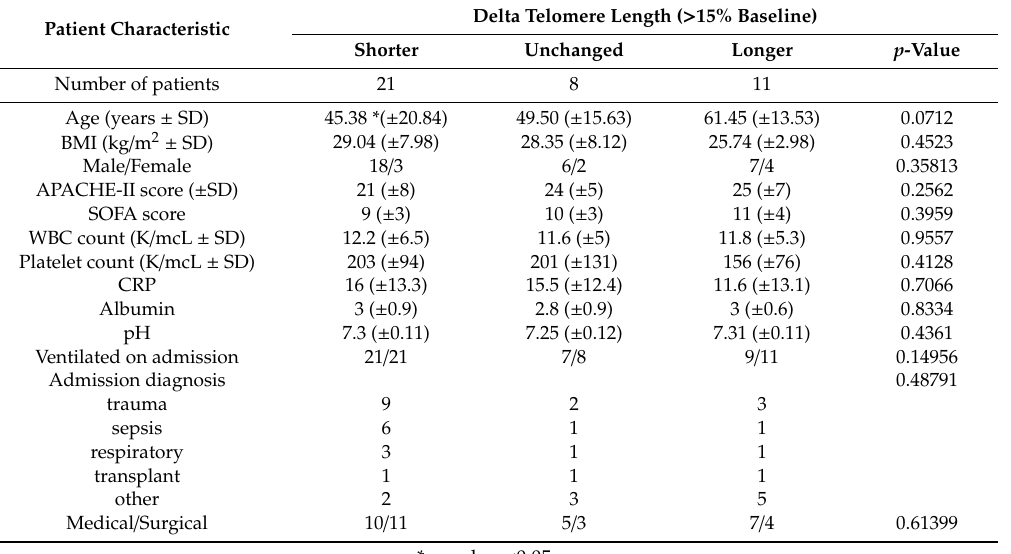
Table 3. Patient characteristics and telomere length changes.